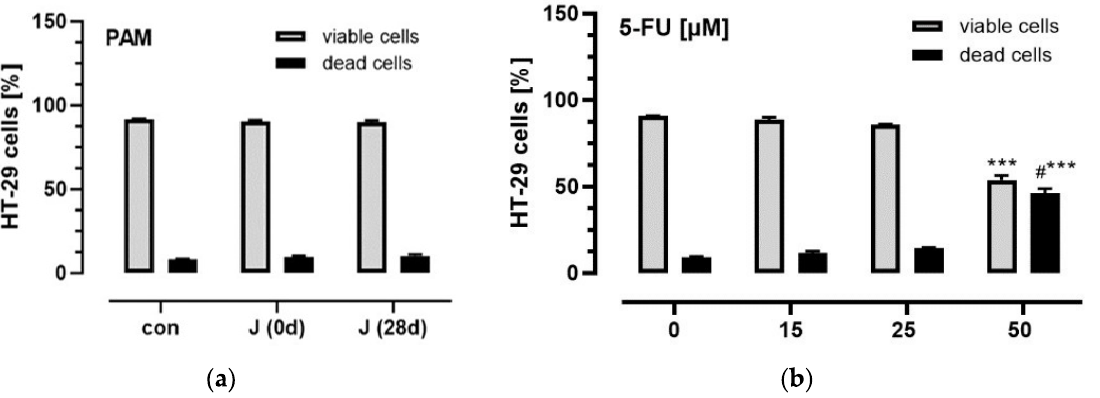
Figure 3. Effects of PAM ( a ) and 5-FU ( b ) on HT-29 cell viability. HT-29 cells were seeded at a density of 1 × 10 5 cells/mL in 24-well plates in complete medium with or without PAM from the anthocyanin- rich juice that were isolated before (J (0 d)) or after 28-day intervention (J (28 d)) or with medium alone (con), as well as with different concentrations of 5-FU. After 36 h incubation, cells were washed twice with PBS, trypsinized and cell viability was measured using a Guava ® Muse ® Cell Analyzer. Data are expressed as bars [%] with standard deviation. Significant differences were calculated with ANOVA with multiple comparison test. Values were different with *** p < 0.001 compared with viable cells of the controls (con) or with #*** p < 0.001 compared with dead cells of the controls ( n =